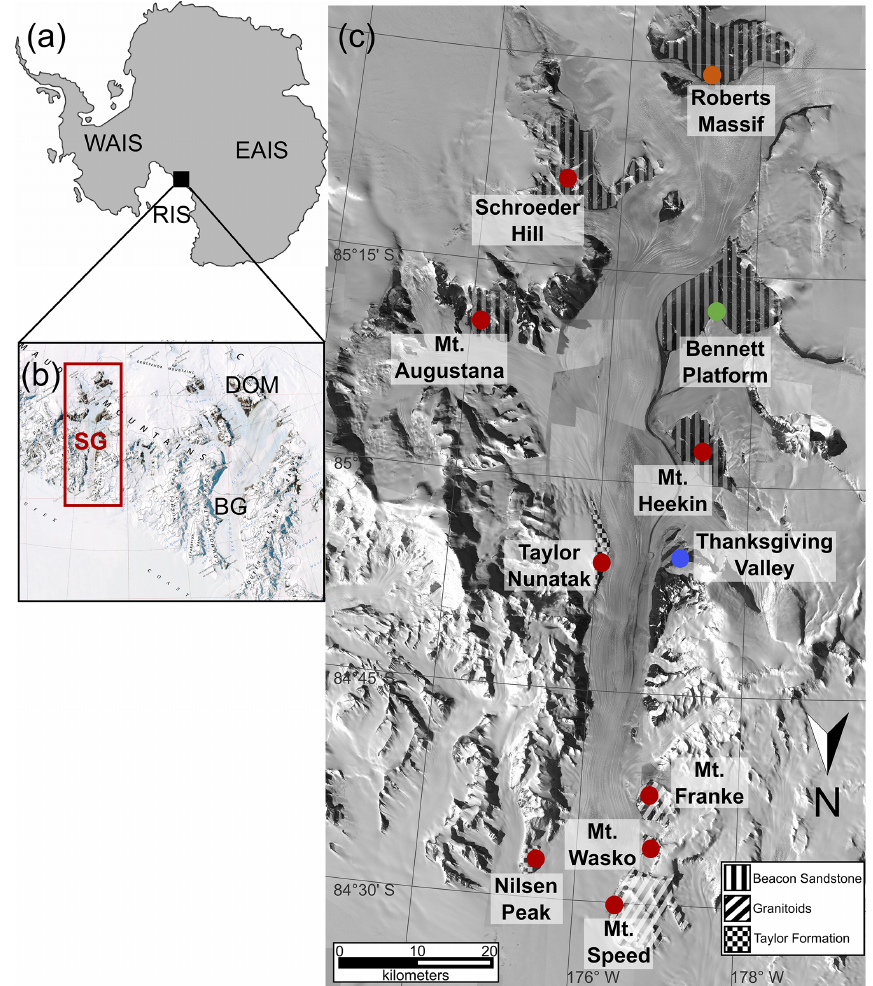
Figure 1. Outline map of the Antarctic continent (a) , the Shackleton Glacier (SG) and Beardmore Glacier (BG) regions (b) , and an overview map of Shackleton Glacier (c) . The red box in (b) encapsulates the Shackleton Glacier region. The red circles in (c) represent our 11 sampling locations, with an emphasis on Roberts Massif (orange), Bennett Platform (green), and Thanksgiving Valley (blue), which have the most comprehensive dataset in this study. The bedrock serves as the primary weathering product for soil formation (Elliot and Fanning, 2008; Paulsen et al., 2004). For reference, the East Antarctic Ice Sheet (EAIS), West Antarctic Ice Sheet (WAIS), Ross Ice Shelf (RIS), and Dominion Range are labeled (a, b) . Base maps were provided by the Polar Geospatial